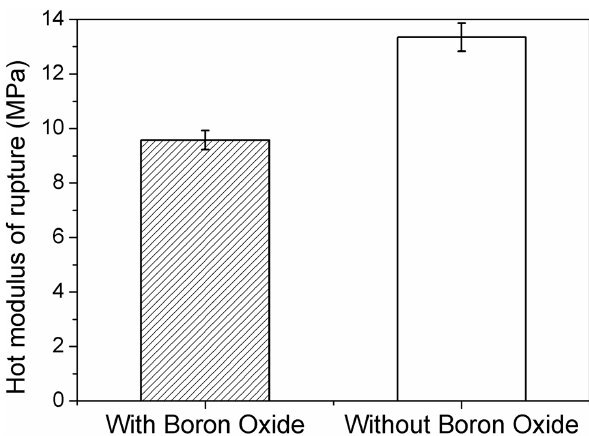
Figure 5: Hot modulus of rupture of castables pre-fired at 1450°C and evaluated at